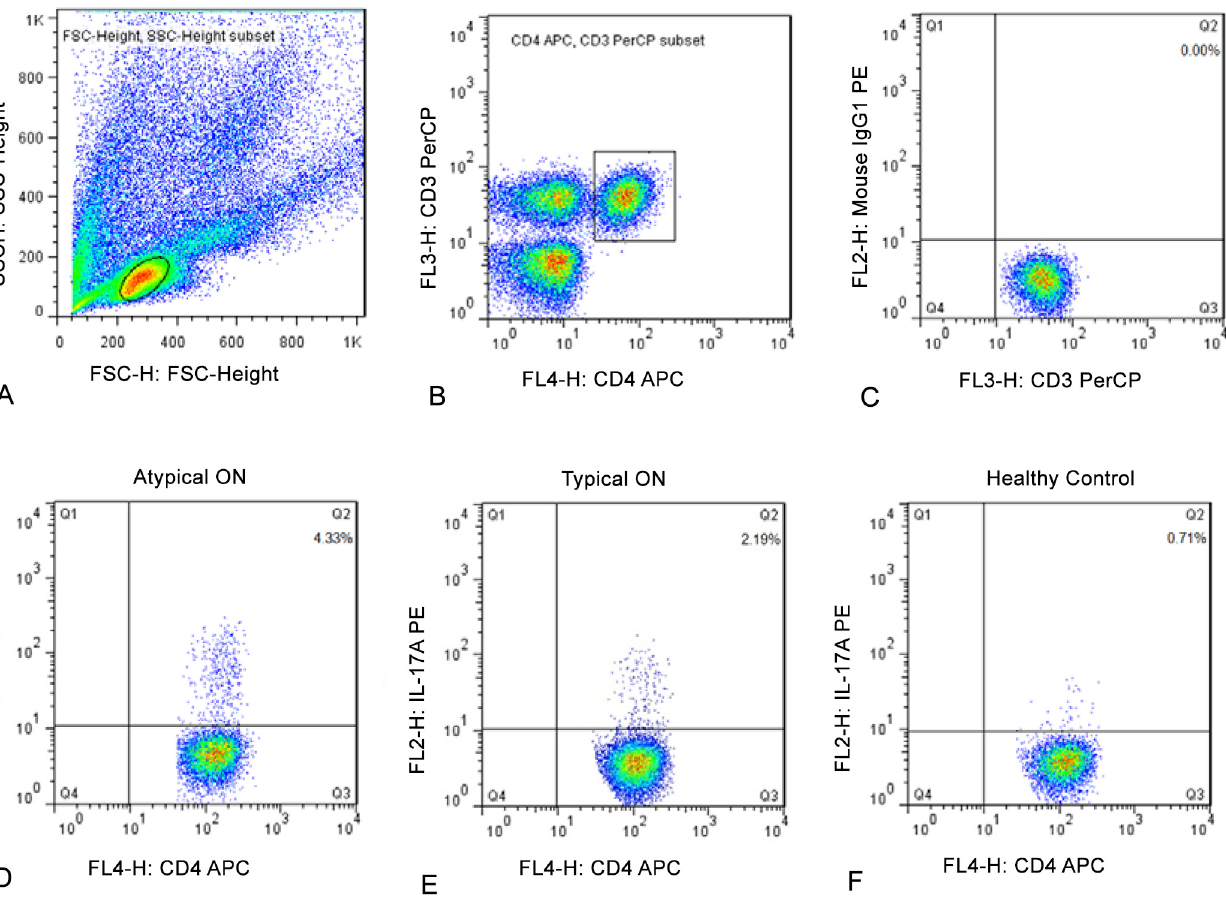
Fig 1. Proportion of CD3+CD4+IL-17A Th17 cells in atypical ON, typical ON and HCs. Lymphocyte (A), CD3+CD4+ T Cells (B), and Isotype control staining of IL-17A (C) in a representative subject. Th17 cells from representative patients with atypical ON (D) or typical ON (E), and from a healthy control subject (F). Note that the proportion of Th17 cells is highest in the atypical ON patient (D), intermediate in the typical ON patient (E) and lowest in the control subject